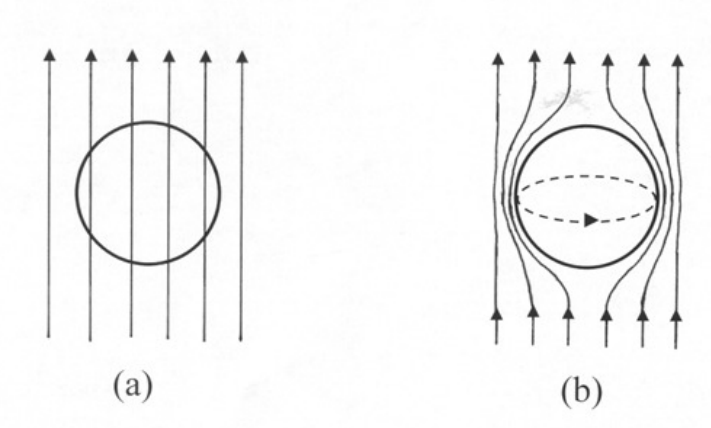
Figure 2. Meissner–Ochsenfeld effect. ( a ) In the normal state above the critical temperature, the spherical superconductor is completely penetrated by the external magnetic field. ( b ) Below the critical temperature, the superconductor completely expels the magnetic field from its interior, as long as the critical magnetic field is not exceeded. This field expulsion is effected by superconducting shielding currents flowing along the surface of the